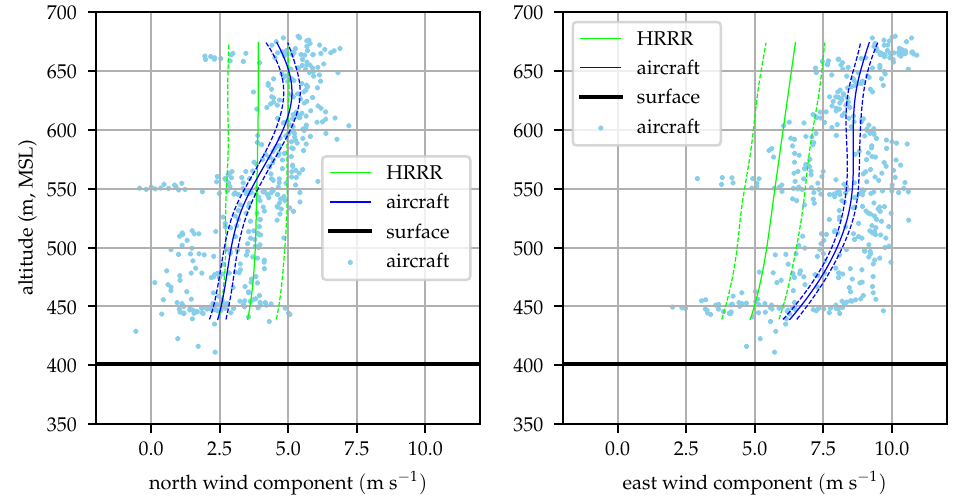
Figure 20. Aircraft measured and HRRR predicted wind profiles at 13:00 local time